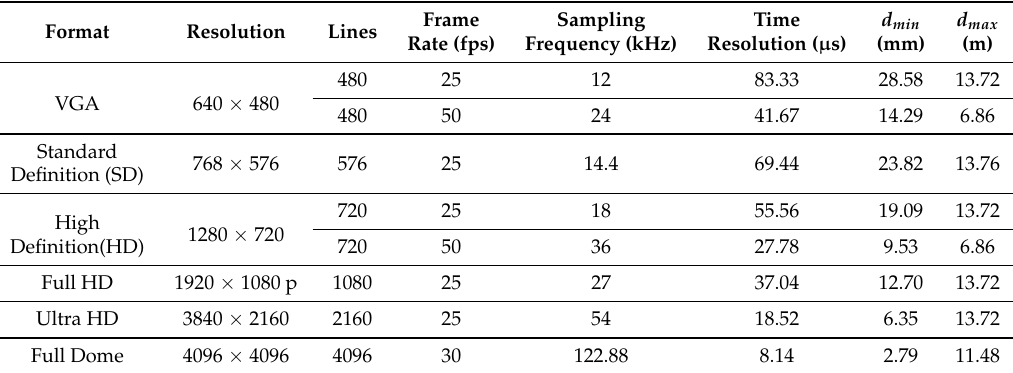
Figure 5. Different illuminated areas corresponding to different distances. ( a ) short distance; ( b ) medium distance; ( c ) long distance. Table 1. Resolution and range for different video